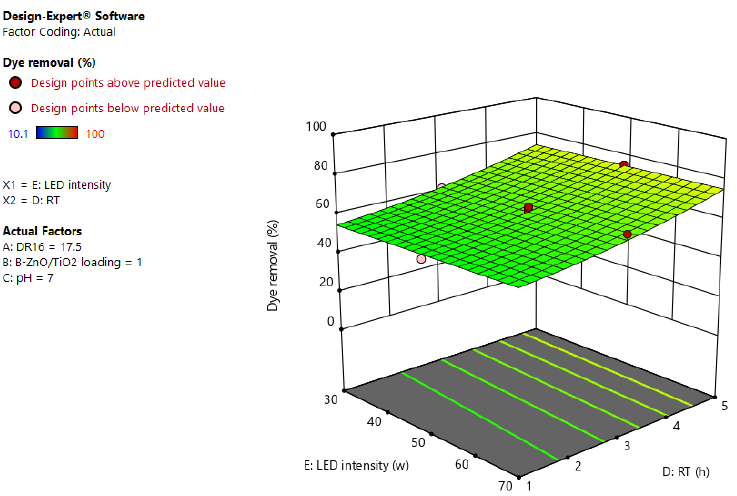
Figure 10. Three-dimensional surface plots of dye removal efficiency as a function of reaction time and LED intensity at [DR16] = 17.5 mg/L, B-ZnO/TiO 2 loading = 1, and pH = 7. Figure 11 reveals the optimization parameters for the two predicted maximum dye removals. Figure 11a shows the optimum conditions to reach the maximum predicted degradation efficiency under 30 W/m 2 light irradiation, and Figure 11b is for 70 W/m 2 light irradiation. From Figure 11, it is seen that both LED intensities applied could achieve maximum degradation efficiency with the highest